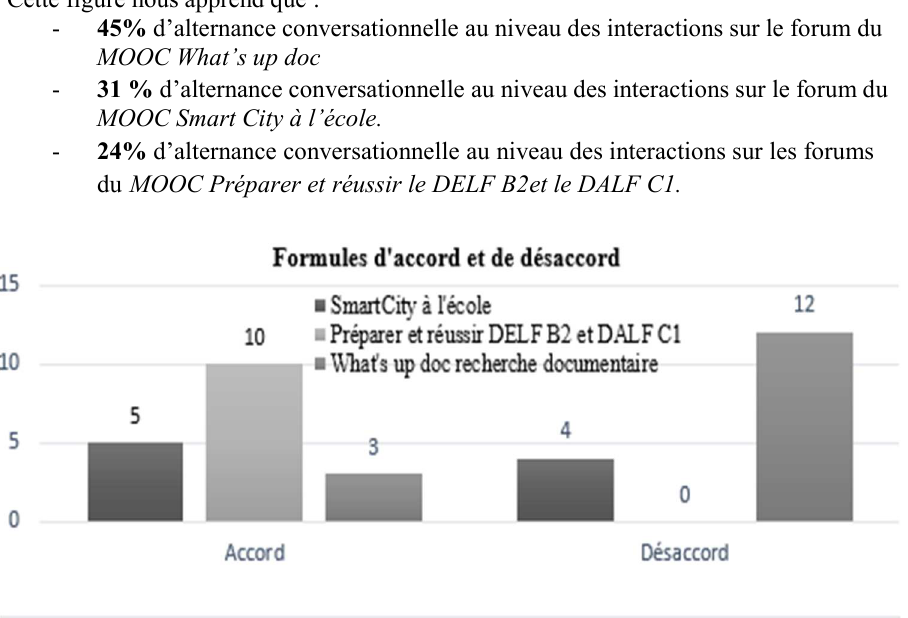
Fig. 4. Les types d'enchaînement entre les